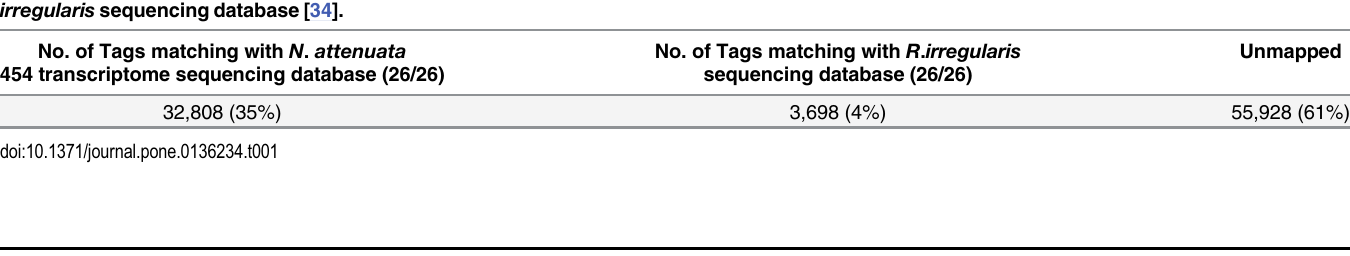
No. of Tags matching with R . irregularis sequencing database